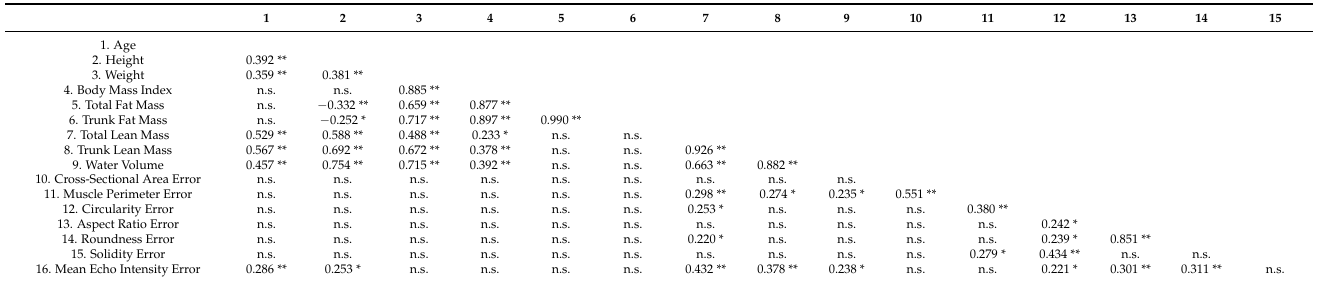
Table 3. Pearson’s product–moment correlation